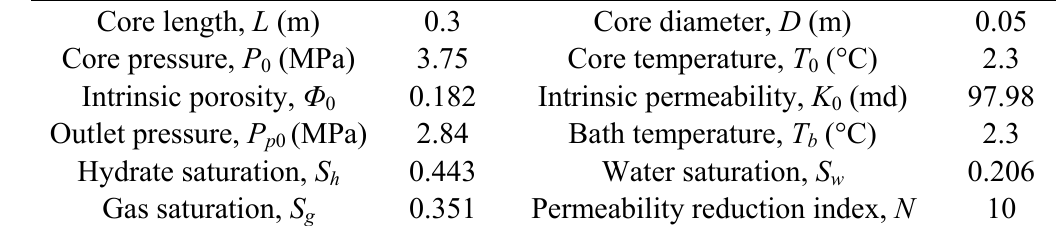
Table 1. Primary physical variable values used in the hydrate depressurization model from the experimental study of Masuda et al .